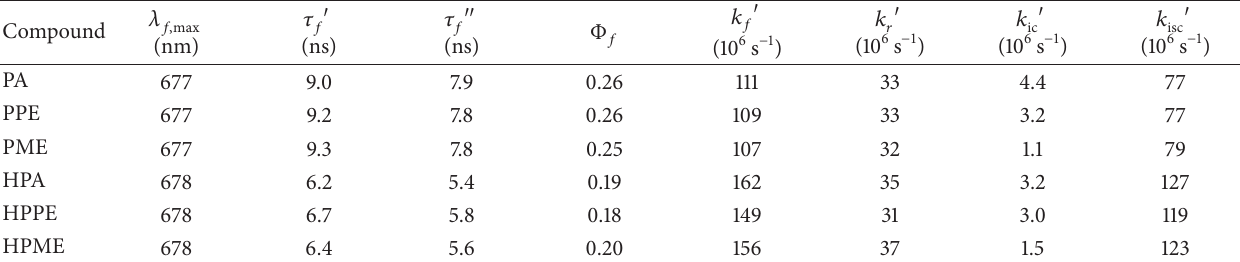
Table 1: Photophysical parameters of the singlet excited state in degassed and air-saturated conditions. Compound